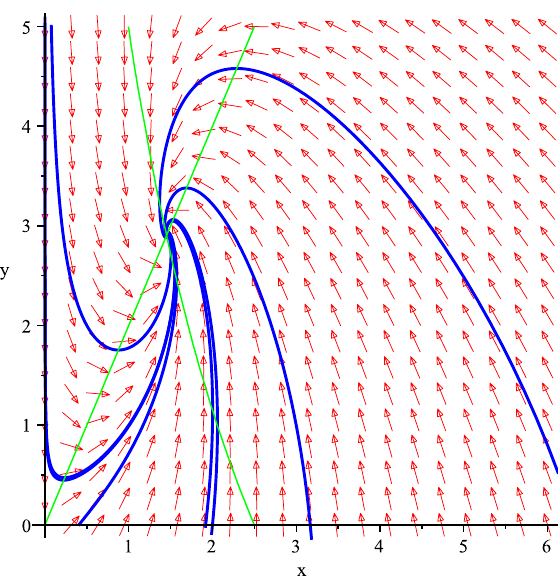
Figure 1. Phase diagram of system (7) with r = 1.5, K = 2.5, D = 2, b = 0.1, a =